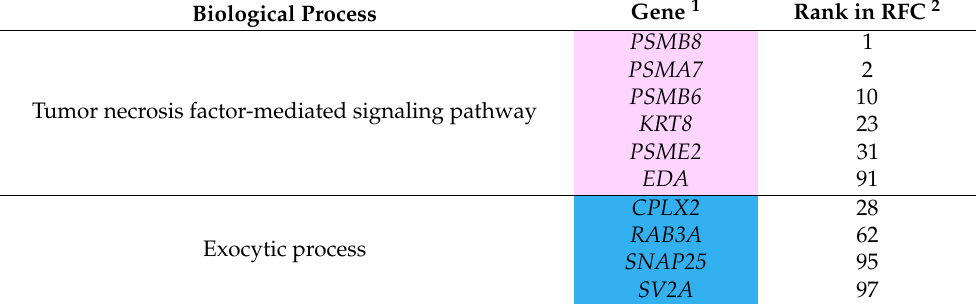
Table 3. Cont. Biological Process Gene 1